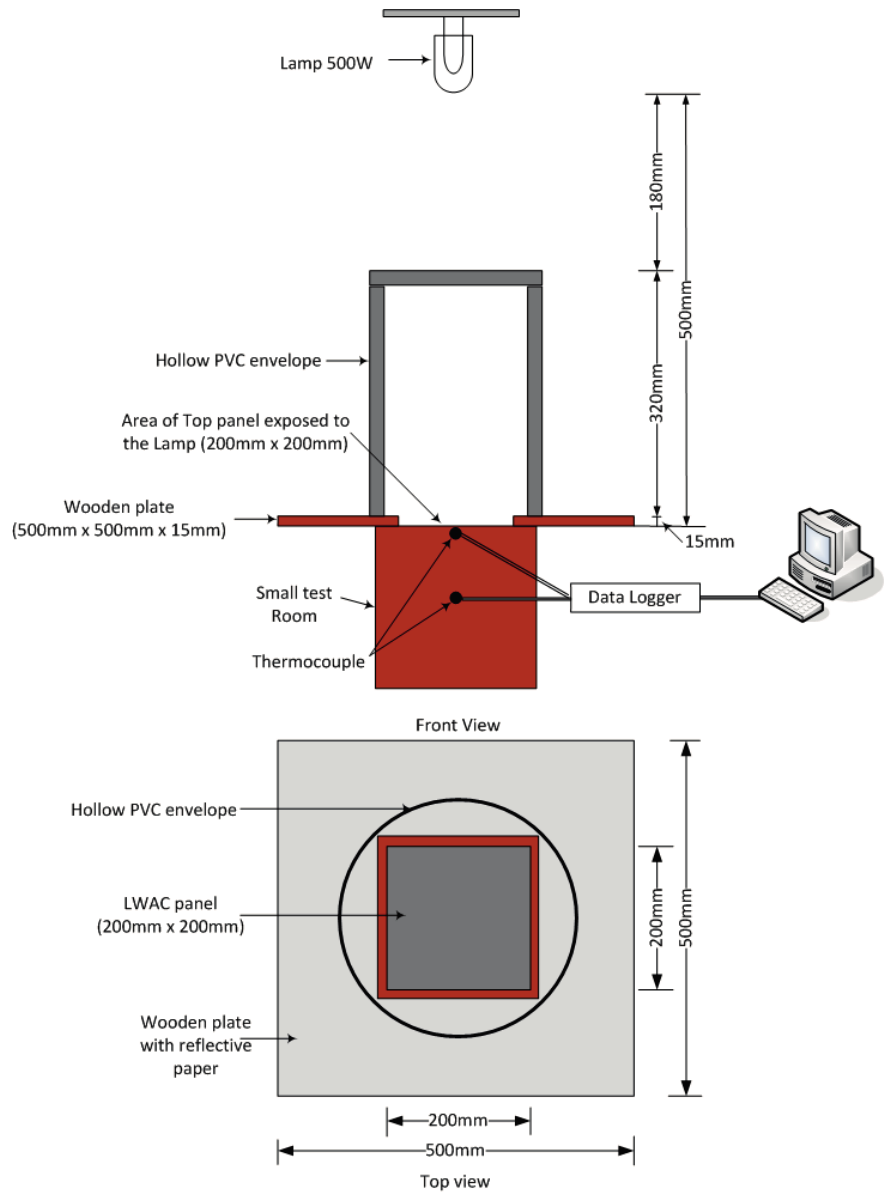
Figure 5. Schematic of thermal performance test–Indoor